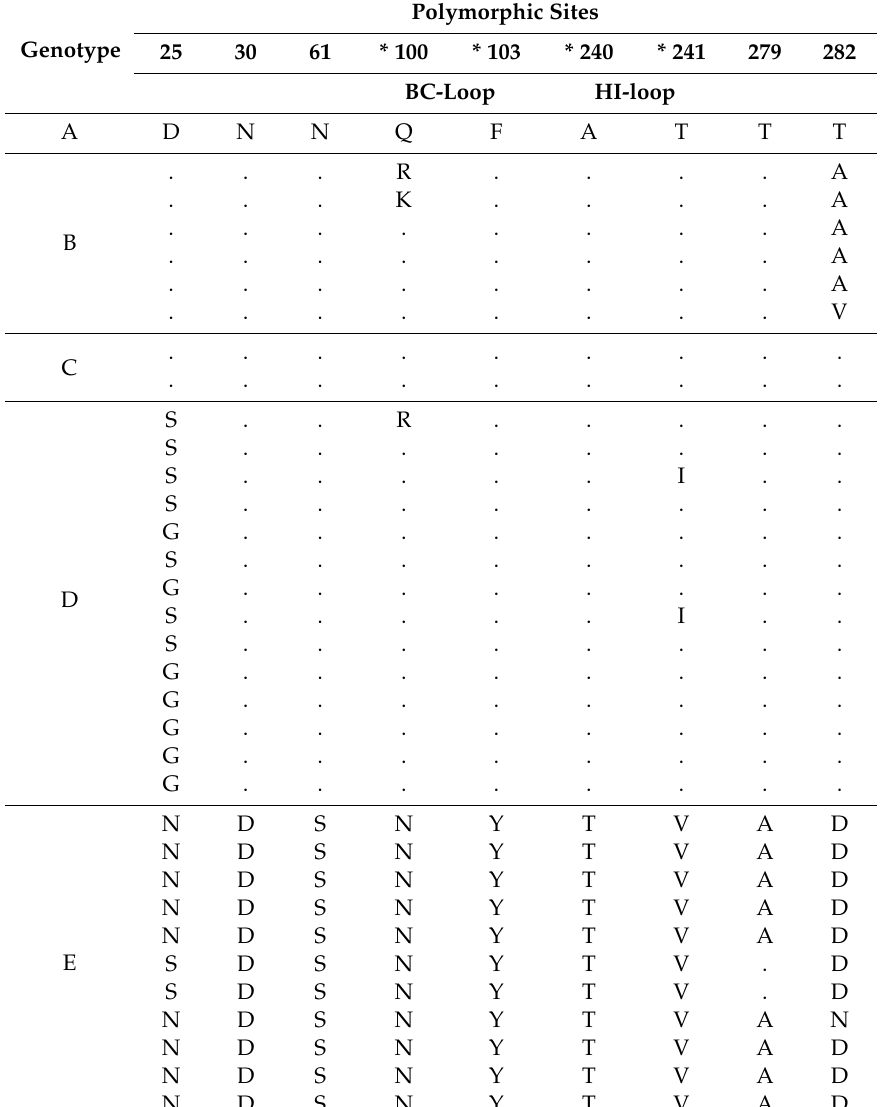
Table 2. Polymorphic amino acid (aa) sites particular to genotype E in VP1 capsid; the same aa as the genotype A prototype strain is indicated by a